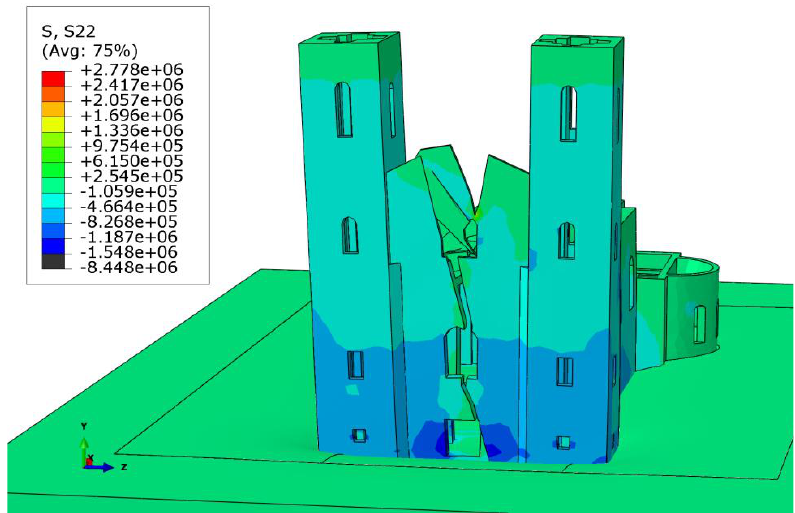
Figure 15. Vertical stresses in the masonry (N/m 2 ).